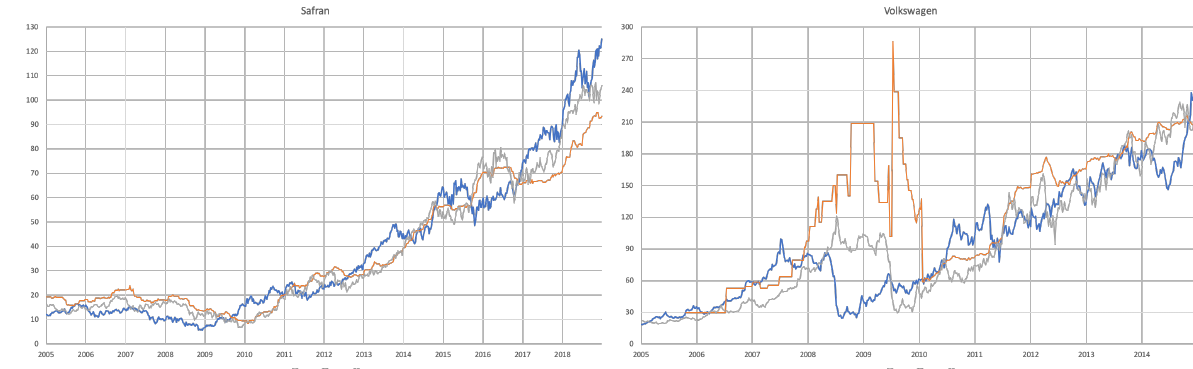
Figure 1. Comparison of target prices (TP) and capitalised prices (CP) with actual future prices (FP). Target prices (TP: orange lines) and capitalised prices (CP: grey lines) forecast for the indicated date t , jointly with actually observed future prices (FP: blue lines) at t , for the 8 best performing companies over the 15-year period of our sample: Adidas, Anheuser, ASML, Essilor, Fresenius, Inditex, Safran,